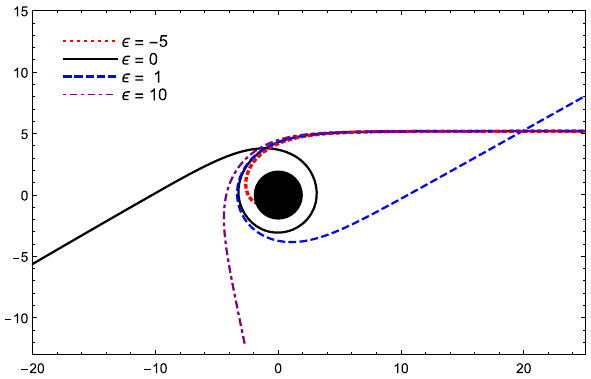
Fig. 5 Nullgeodesicswith b = 5 . 2 M ,consideringdifferentchoicesof ε . We note that the JPBH has a stronger influence in photon trajectories for smaller values of the deformation parameter